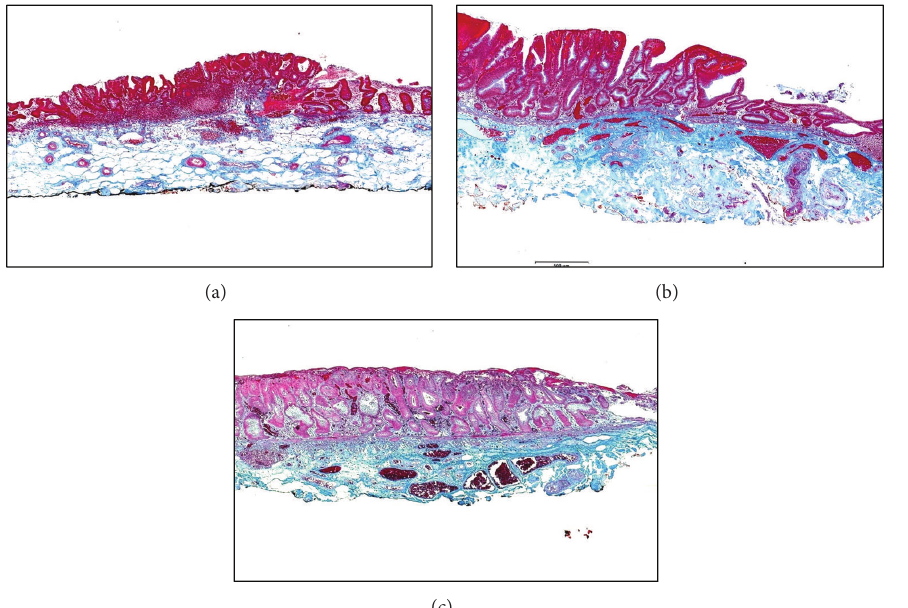
Figure 4: Sections of laterally spreading tumor-nongranular (LST-NG) type with different degrees of submucosal fibrosis. (a) F0: no fibrosis, honeycomb-like appearance throughout; (b) F1: mild fibrosis, intensity of staining was high in ≺ 50% of the sample; (c) F2: severe fibrosis, intensity of staining was high almost throughout (Masson’s trichrome stain, original magnification ×